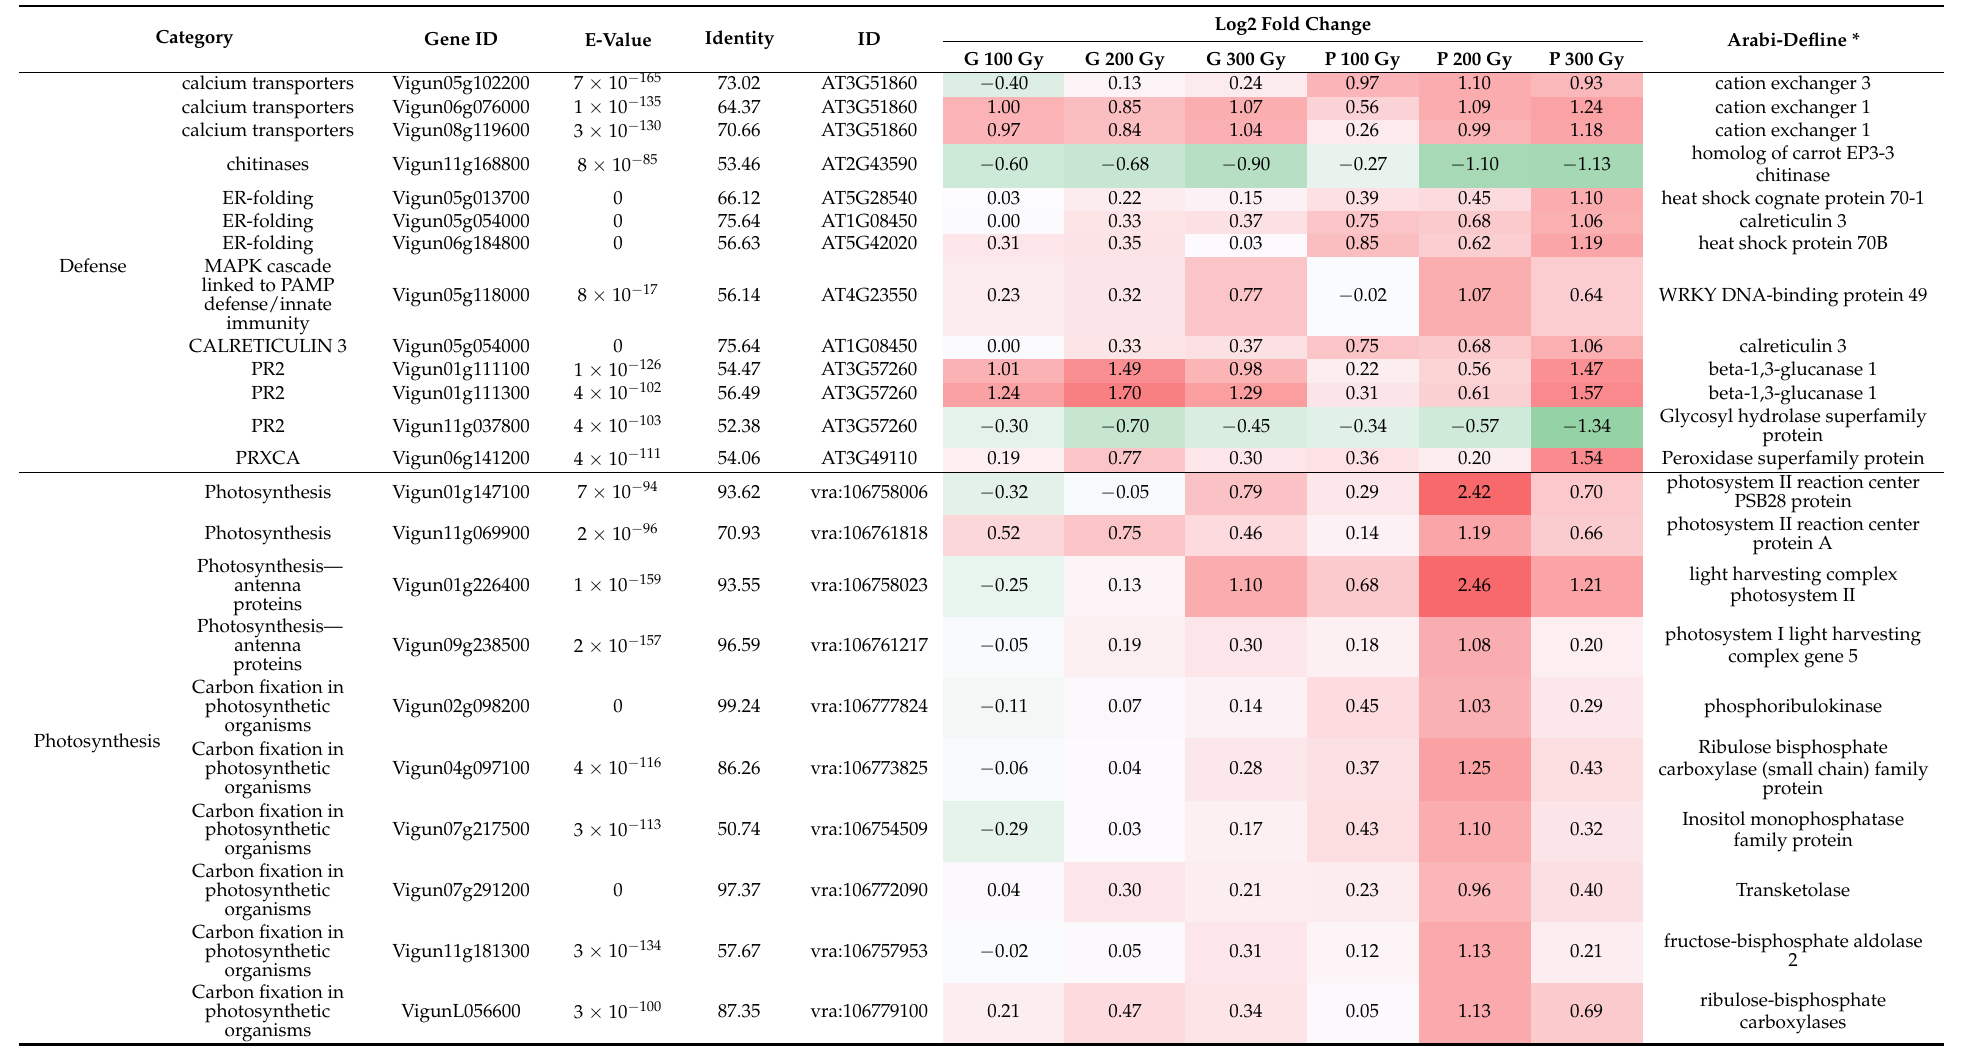
Table 3. The differently expressed genes (DEGs) list as related to defense, photosynthesis, and ROS of cowpeas exposed to different dose rates of gamma-rays and proton-beams.